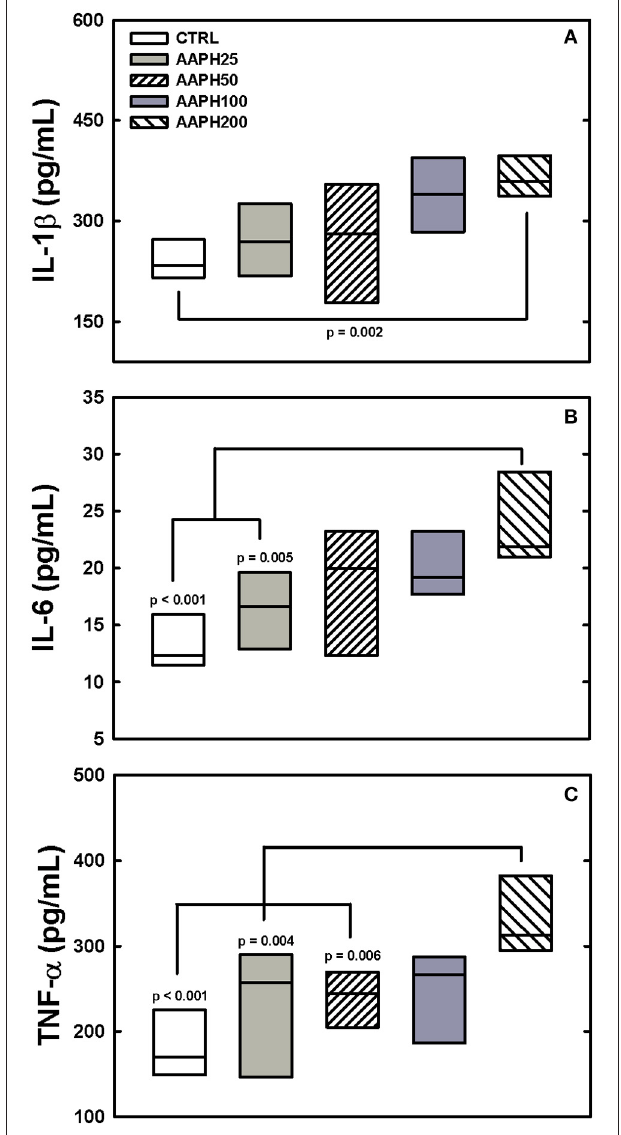
FIGURE 4 | Levels of citokines. IL-1 β , IL-6, and TNF- α (panels A–C , respectively) were measured in lung homogenate by ELISA 72 h after exposure of the animals to saline solution (CTRL) or different amounts of 2,2 ′ -azobis (2-amidinopropane) dihydrochloride (AAPH25, 50, 100, and 200 mg/kg in saline solution). In panel (A) AAPH200 IL-1 β was larger than in CTRL animals. In panel (B) AAPH200 IL-6 was greater than in CTRL and AAPH25 rats that did not differ. Panel (C) shows that AAPH200 TNF- α was greater than in CTRL, AAAPH25 and AAPH50, which did not differ among them. Boxes show interquartile (25–75%) range and horizontal lines represent median of 6 animals in each group. P -values are 50 µ m. =